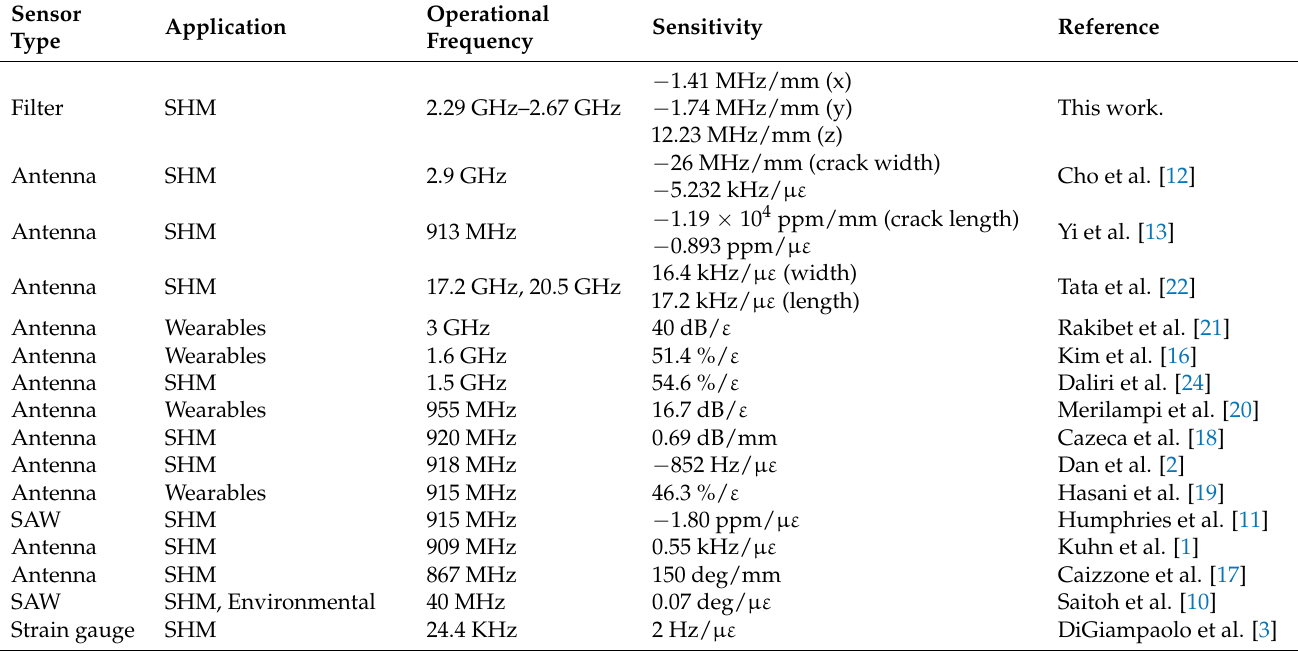
Table 3. Comparison of reported crack- and strain-monitoring